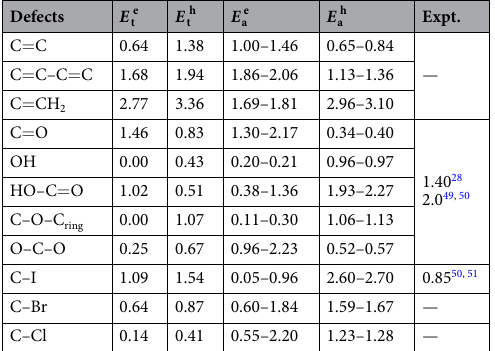
Table 1. Computed trap depths ( E te and E th ) and electron and hole activation energies ( E ae and E ah ), given in eV, of PE with chemical defects. Experimental values are given when